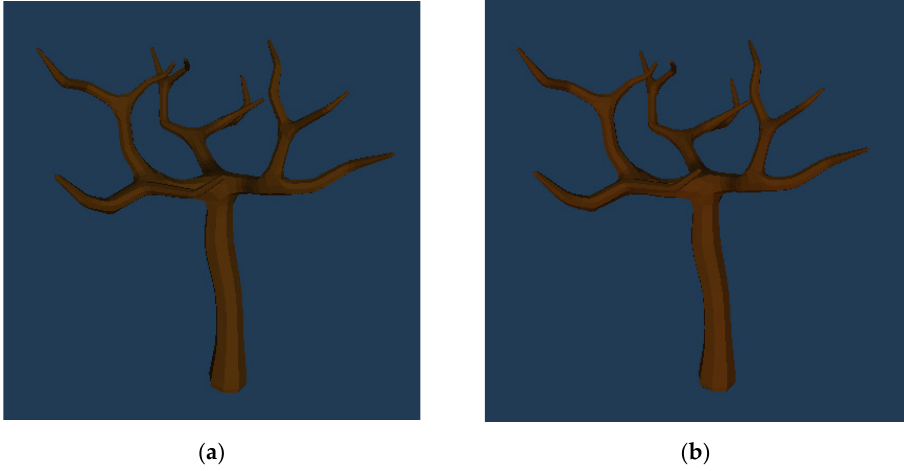
Figure 7. ( a ) Tree model from the improved version of the game. ( b ) Tree model from the non- improved version of the game.